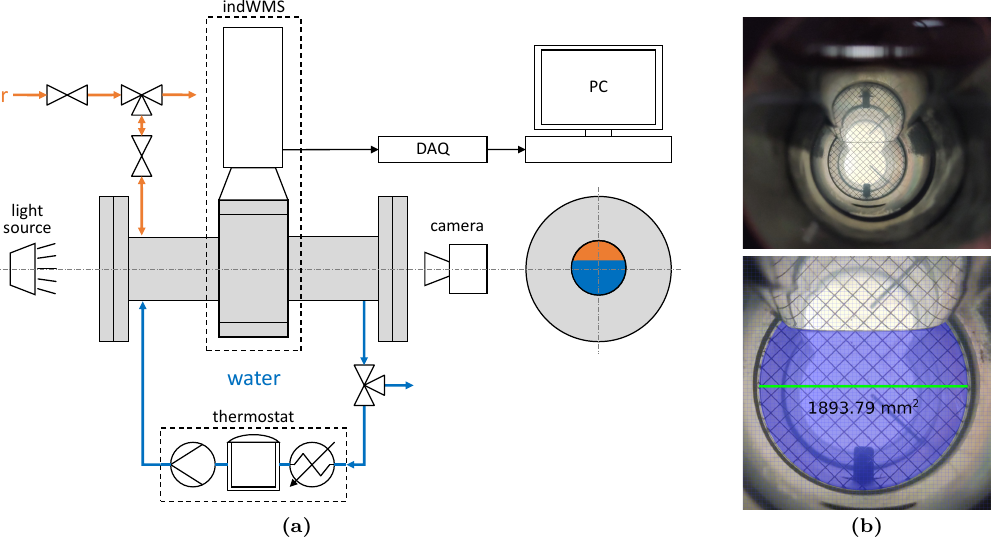
Figure 5. ( a ) Experimental setup for verifying phase fraction measurement combined with tempera- ture compensation; ( b ) images of pipe cross-section recorded by high-resolution camera: ( top ) raw image, ( bottom ) cropped and scaled image with calculation of A liquid